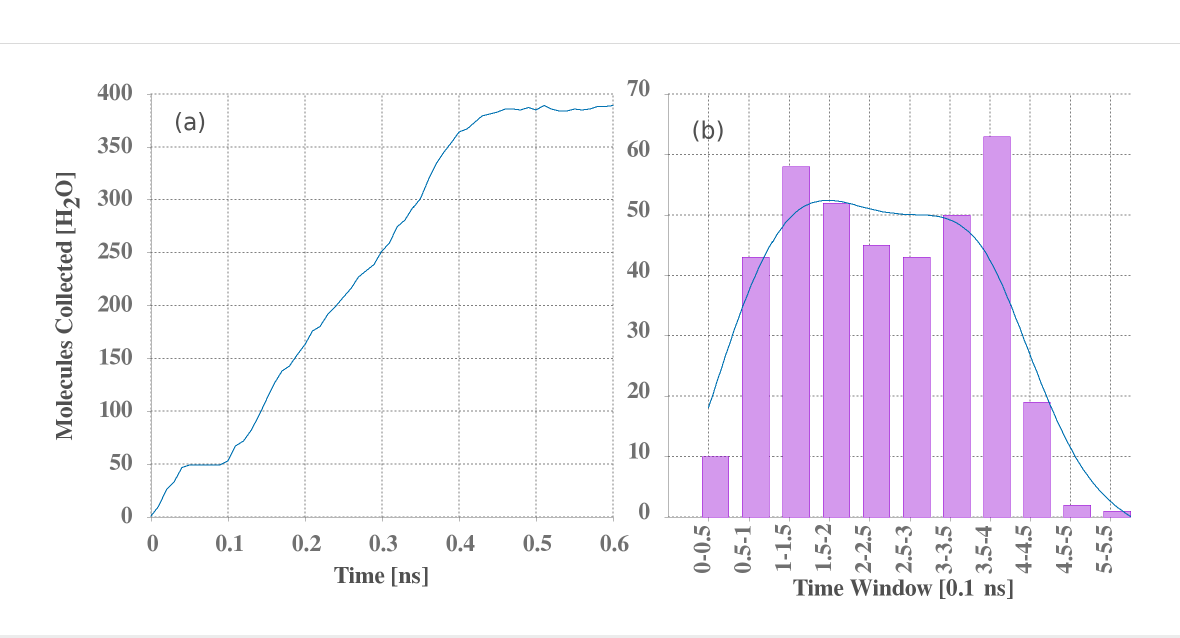
Figure 5: (a) Number and (b) histogram of collected water molecules as functions of (a) the time and (b) time intervals.